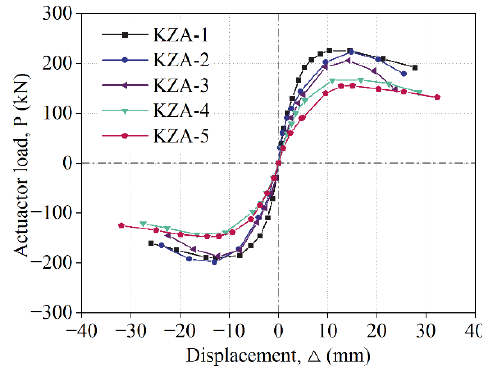
Figure 10. Skeleton curves of specimens.